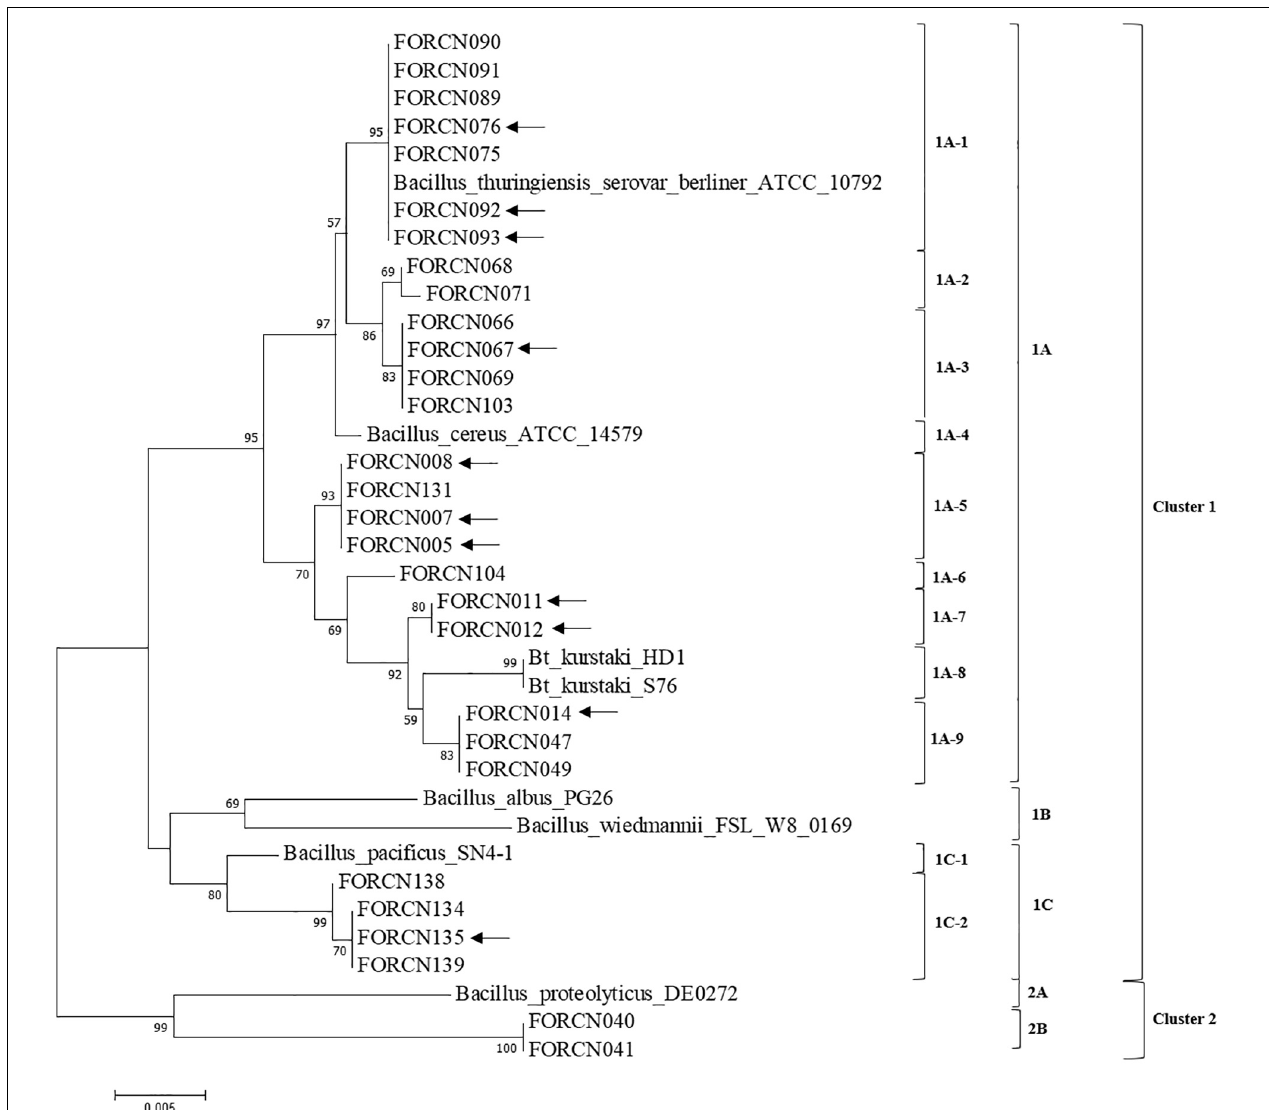
FIGURE 7 | Phylogenetic tree using the Neighbor-Joining method estimated from the concatenated sequences of four conserved genes ( glp , gmk , pta, and tpi ). The evolutionary distances were calculated using the Tamura 3-parameter model as indicated by the model test function of the MEGA 7.0 program. Bootstrap values are shown when the relationships represented have been observed in at least 50% of 500 replicates. The scale bar represents the number of base pair substitutions per site. Sequences of species of the genus Bacillus deposited in the NCBI database were used to group the bacterial isolates in the dendrogram. The arrows indicate the strains with positive results for the amplification of XRE transcriptional